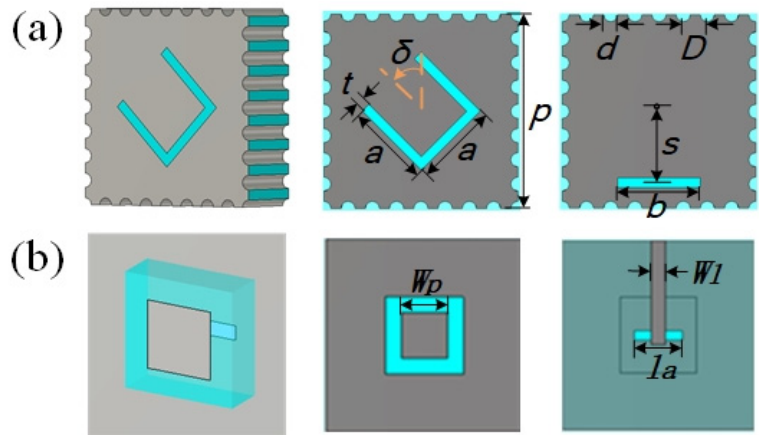
Figure 2. Schematic diagram of the meta-surface FP resonator antenna. ( a ) The structural parameters of unit cell are a = 3.5 mm, d = 0.6 mm, D = 1.02 mm, p = 8.16 mm, and b = 3.47 mm, and all slits have a width of t = 0.4 mm. The C-gap in top layer is demonstrated to have a rotating angle of δ . ( b ) Feed of the slot coupling patch antenna with physical parameters of Wp = 4.7 mm, W l = 1.46 mm, and la = 5 mm.